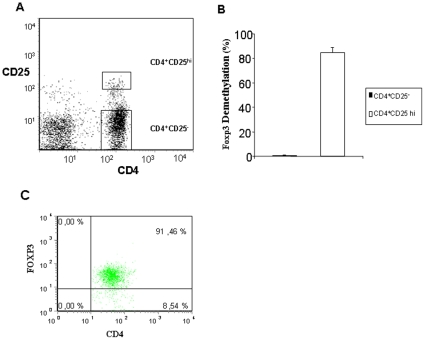
FOXP3 demethylation in isolated CD4CD25− and CD4CD25hi cells.A/B. CD4CD25− and CD4CD25hi cells were isolated with Dako MoFlow. DNA was extracted and demethylation (%) of FOXP3 was measured with real-time PCR. C. Intracellular FOXP3 protein was measured in CD4CD25hi cells as described in methods. N = 5, mean ± SEM were shown in B, one representative sample for A/C.